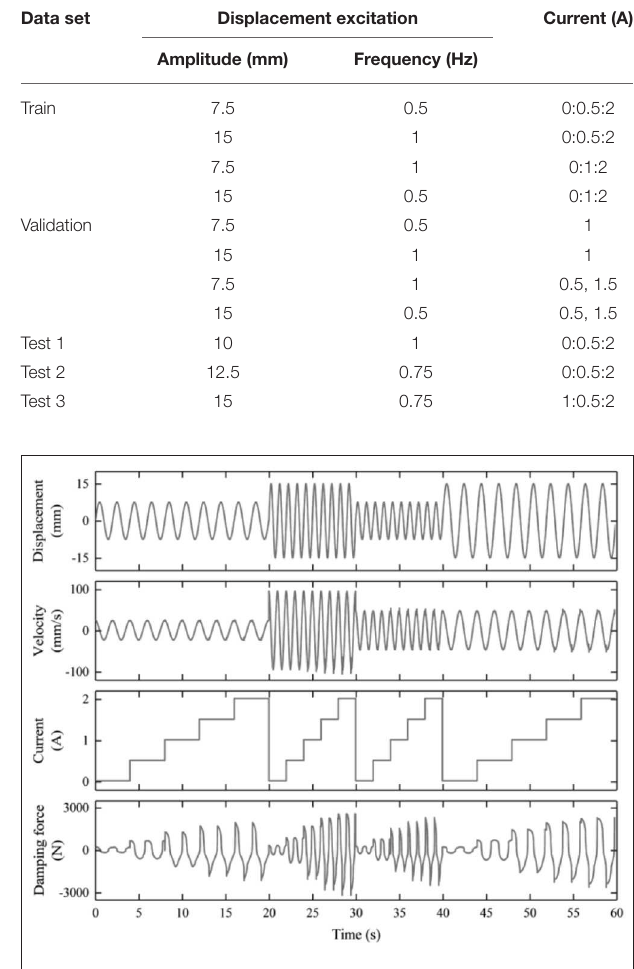
FIGURE 3 | Training